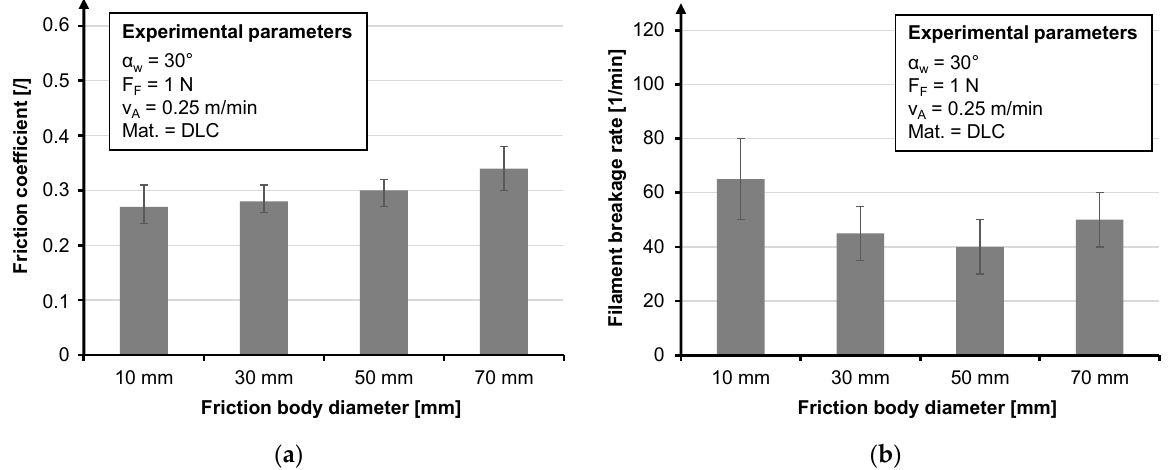
Figure 13. Influence of the friction body diameter regarding the friction coefficient ( a ) and influence of the friction body diameter regarding the filament breakage rate ( b ).